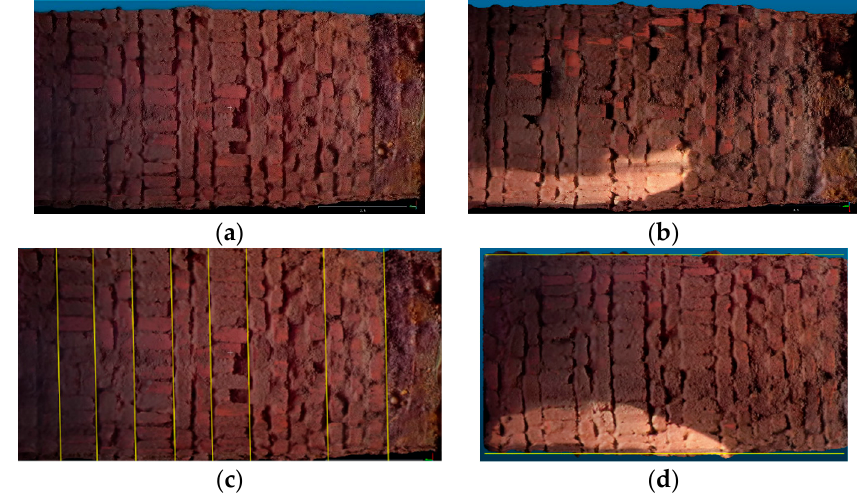
Figure 6. Model texture details ( a , b ) and relative accuracy analysis ( c , d ).